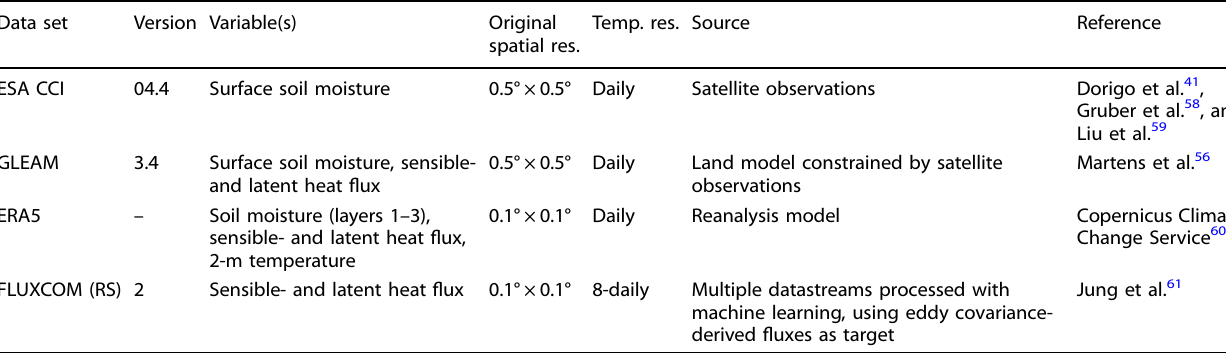
Table 1. Data sets used in this